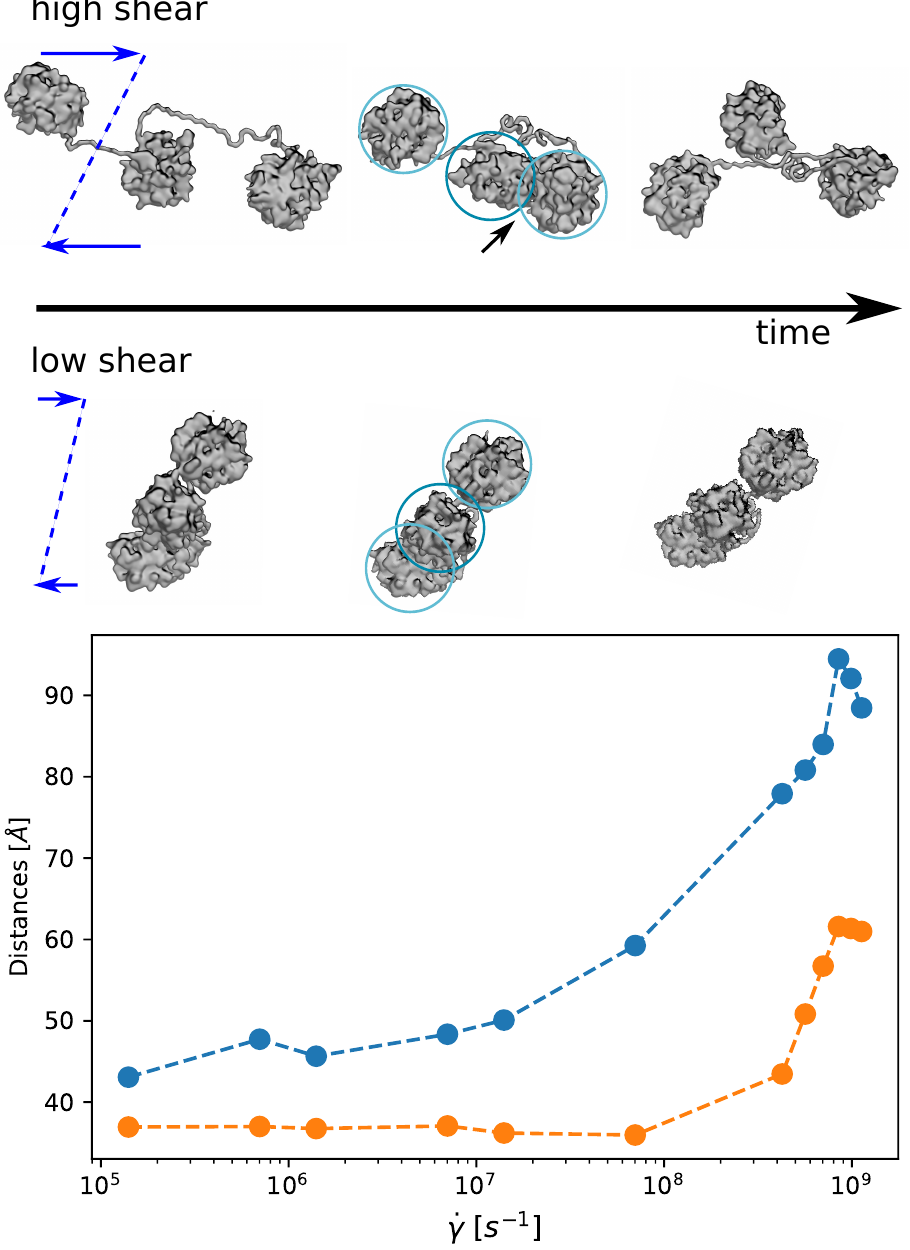
Figure 10. Elongation/Collapse dynamics. Top. Molecular representation of the A1A2A3 system moving in the shear flow at high and low shear rates. At low shear rate the three domains stay collapsed, while at high shear rate they cyclically extend. Bottom. Average inter-domain distances for A1A2 (blue) and A1A3 (orange) as a function of the shear